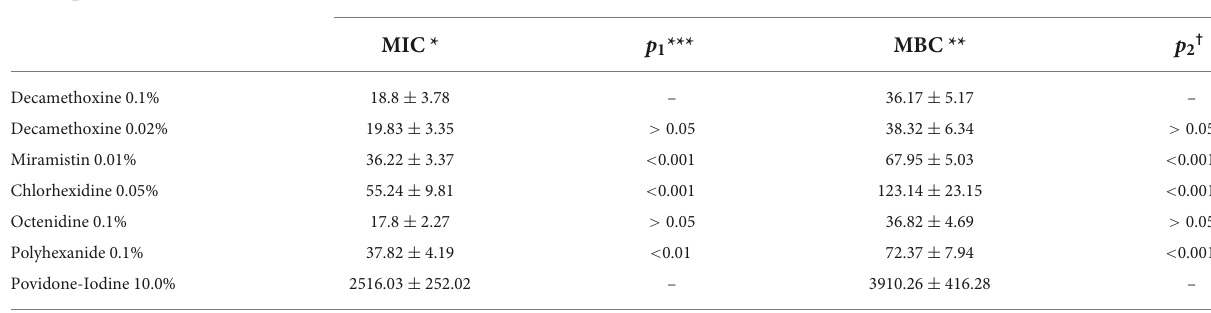
TABLE 1 Characteristics of susceptibility to antiseptics of clinical strains of A. baumannii isolated from patients with microbial complications of combat wounds, in µ g/ml (arithmetic mean ± arithmetic mean error: M ± m). Antiseptics